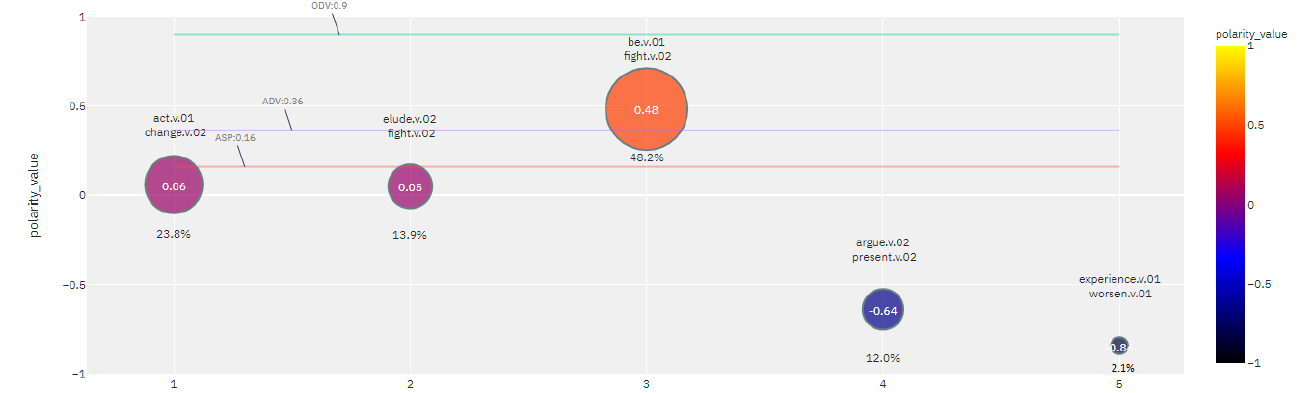
Figure 9. Sentiment potential ( SP ) of lexeme fight-v calculated with SenticNet 6 polarity-value; propagated on pruned graph clusters of 15 best ranked collocates in the first degree and 15 collocates in the second degree within ententen13